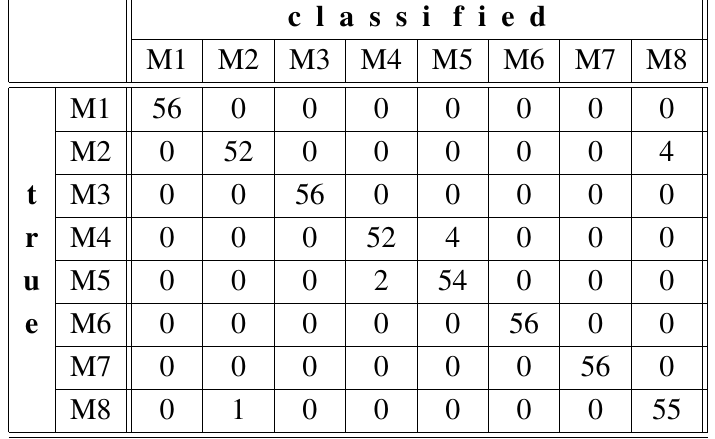
Table 10. Confusion matrix for DTW-1 (LOO cross validation, 96.0%).